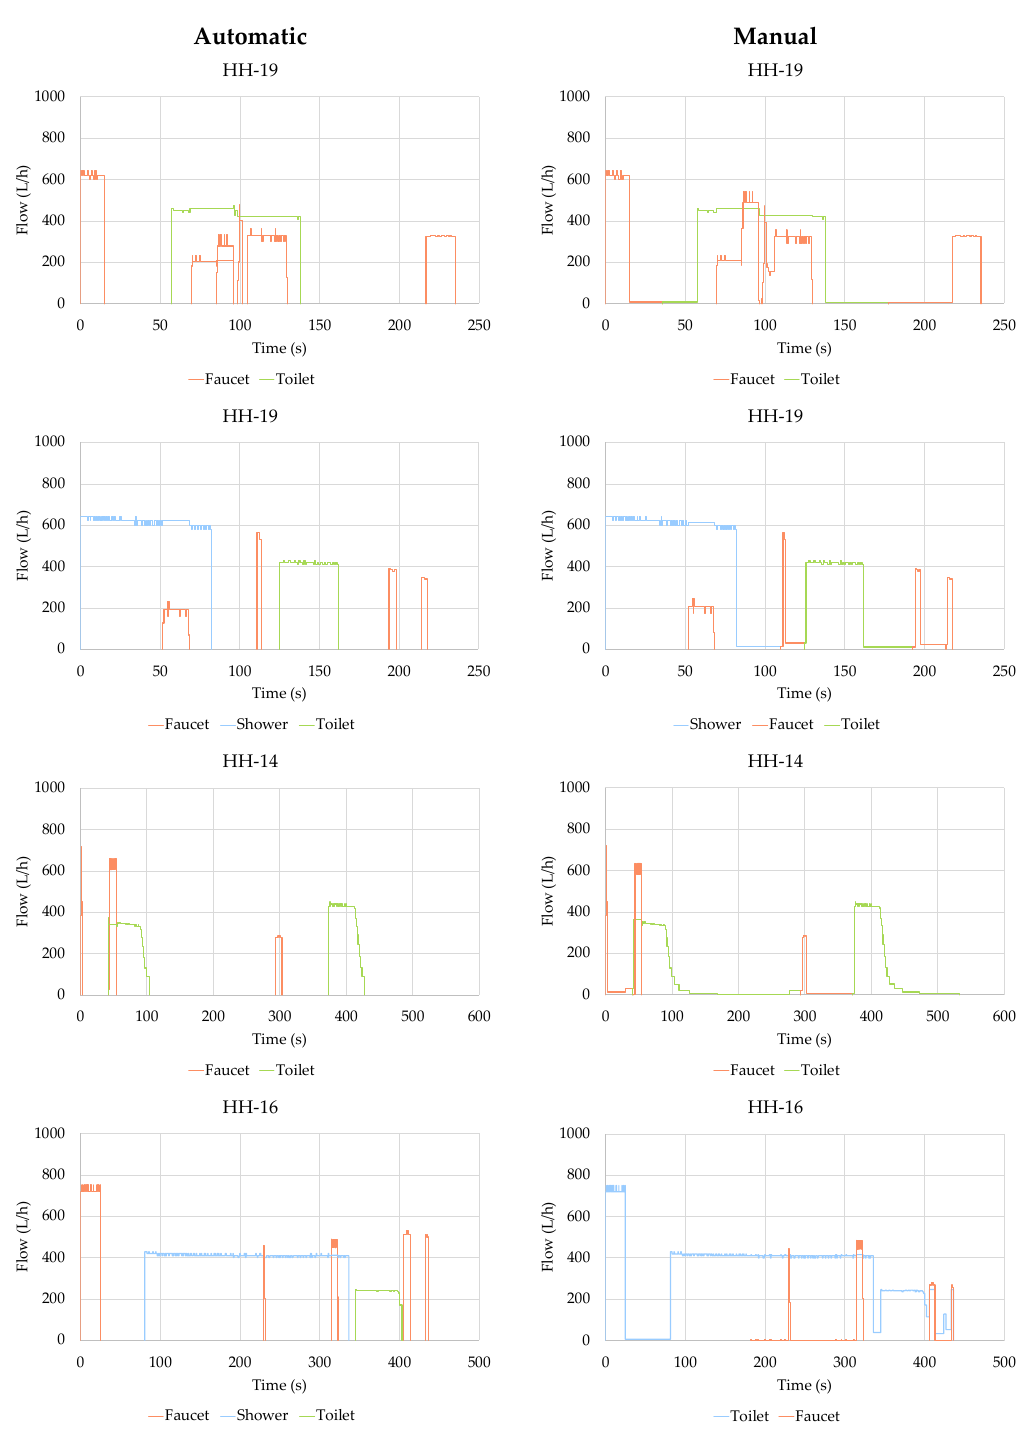
Figure A3 . Examples of Manual vs. Automatic Disaggregation from R2 study. Figure A3. Examples of Manual vs. Automatic Disaggregation from R2